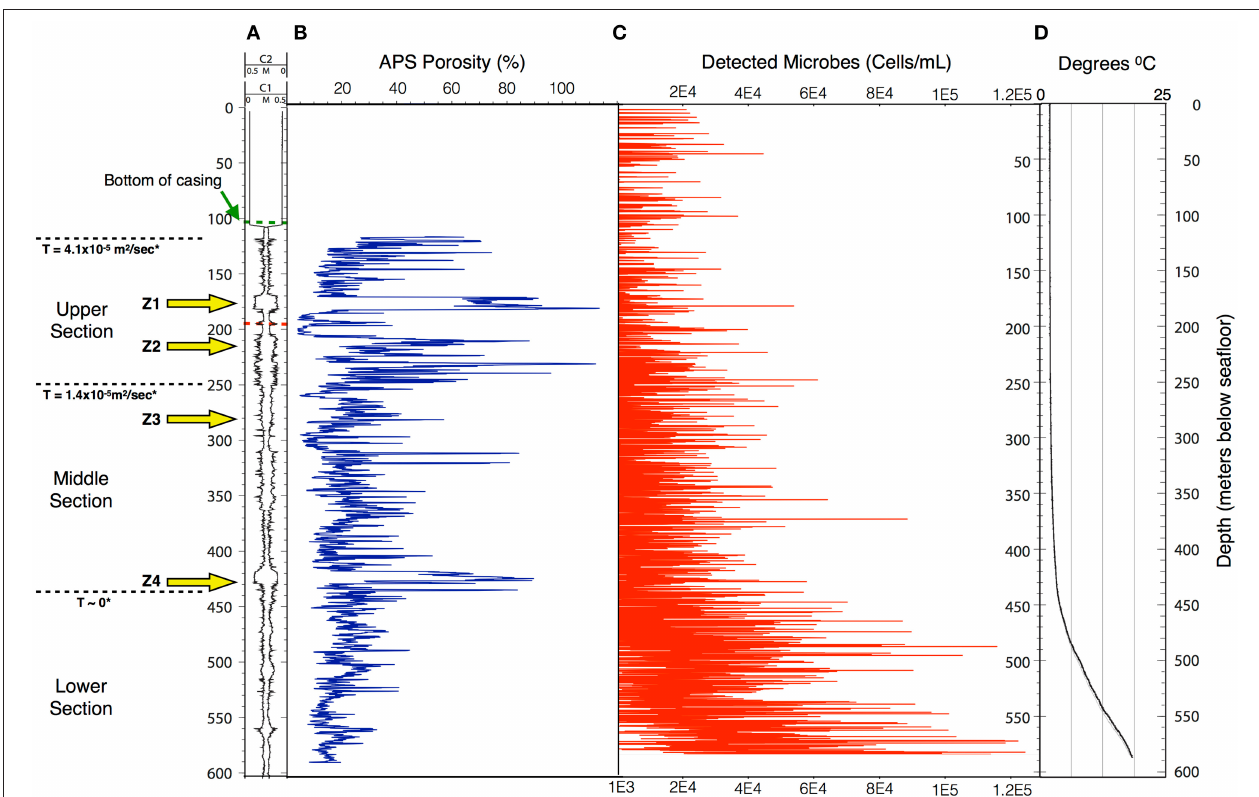
FIGURE 3 | The structure of the microbe-like signature within Hole 395A appears to be indicative of settling. The overall density of microbes increases with depth in Hole 395A. (A) Caliper data taken for Hole 395A during ODP Leg 174B; C1 = FMS pass 1, C2 = FMS pass 2; green hash line = location of bottom of casing, red hash line = location of drill pipe for second logging attempt during IODP Expedition 336; location of inflow zones (yellow arrows) is based on spontaneous potential log from Hole 395A collected during ODP Leg 174B; T = hydraulic transmissivity from Morin et al. (1992); based on transmissivity values, the hole was portioned into three sections. (B) APS porosity data collected during ODP Leg 174B. (C) Scatter plot showing the density range of detected spore signals during the first downlog; the density range is dependent on the excitation source’s depth of penetration through the water column; red circles = upper estimate, black circles = lower estimate.; for modeling purposes. (D) Temperature profile of Hole 395A. Data is from ODP Leg 174B and IODP Expedition 336. The temperature profile suggests a hydrologically isolated lower portion, which would be consistent with the observed structure of the microbial